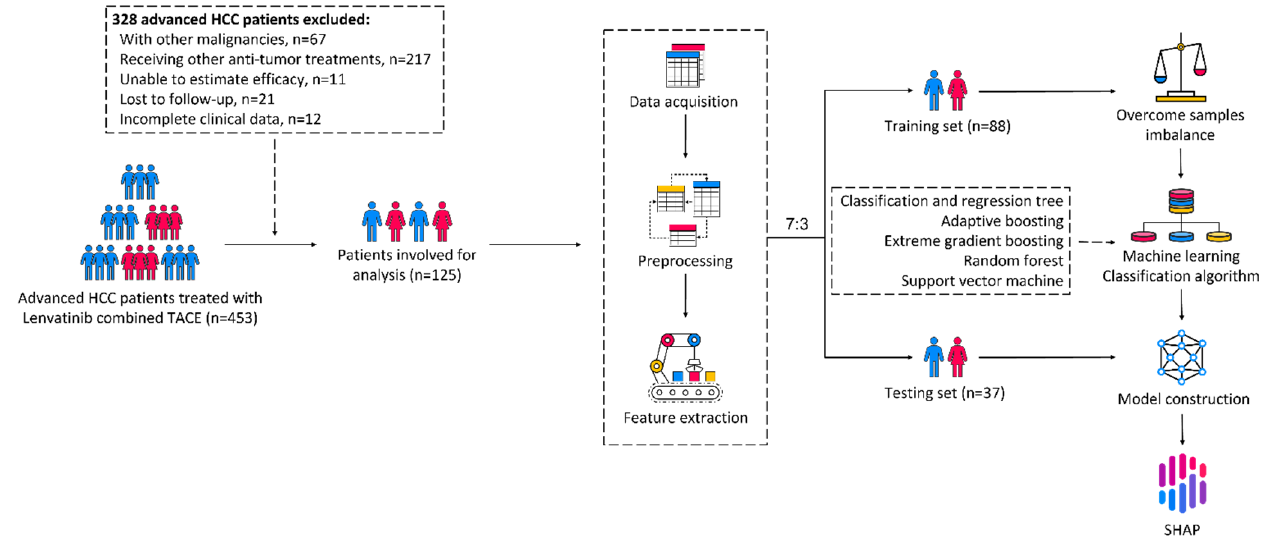
Figure 1. Flow chart of the study. Table 1. Demographic characteristics, pretreatment serum biomarkers, and tumor characteristics of the training set and testing set. All Patients ( n = 125) Training Set ( n = vided the patients into a training set ( n = 88) and testing set ( n = 37) according to a ratio of 7:3 and compared all the features between the two groups. The demographic characteris- tics, pretreatment serum biomarkers, and tumor characteristics are shown in Table 1. The detailed raw data of 125 unresectable HCC patients were available in the Supplementary File S1.